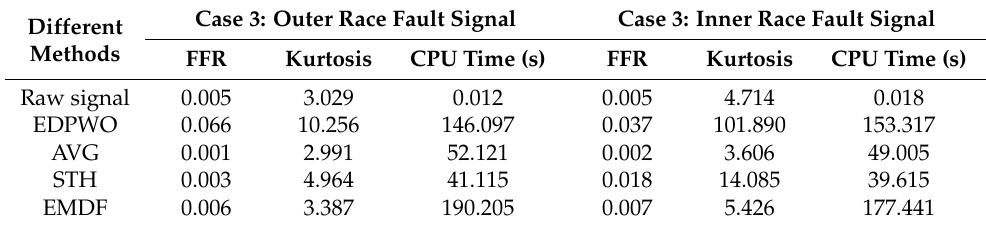
Table 12. Quantitative comparison of statistical indicators of different methods in case